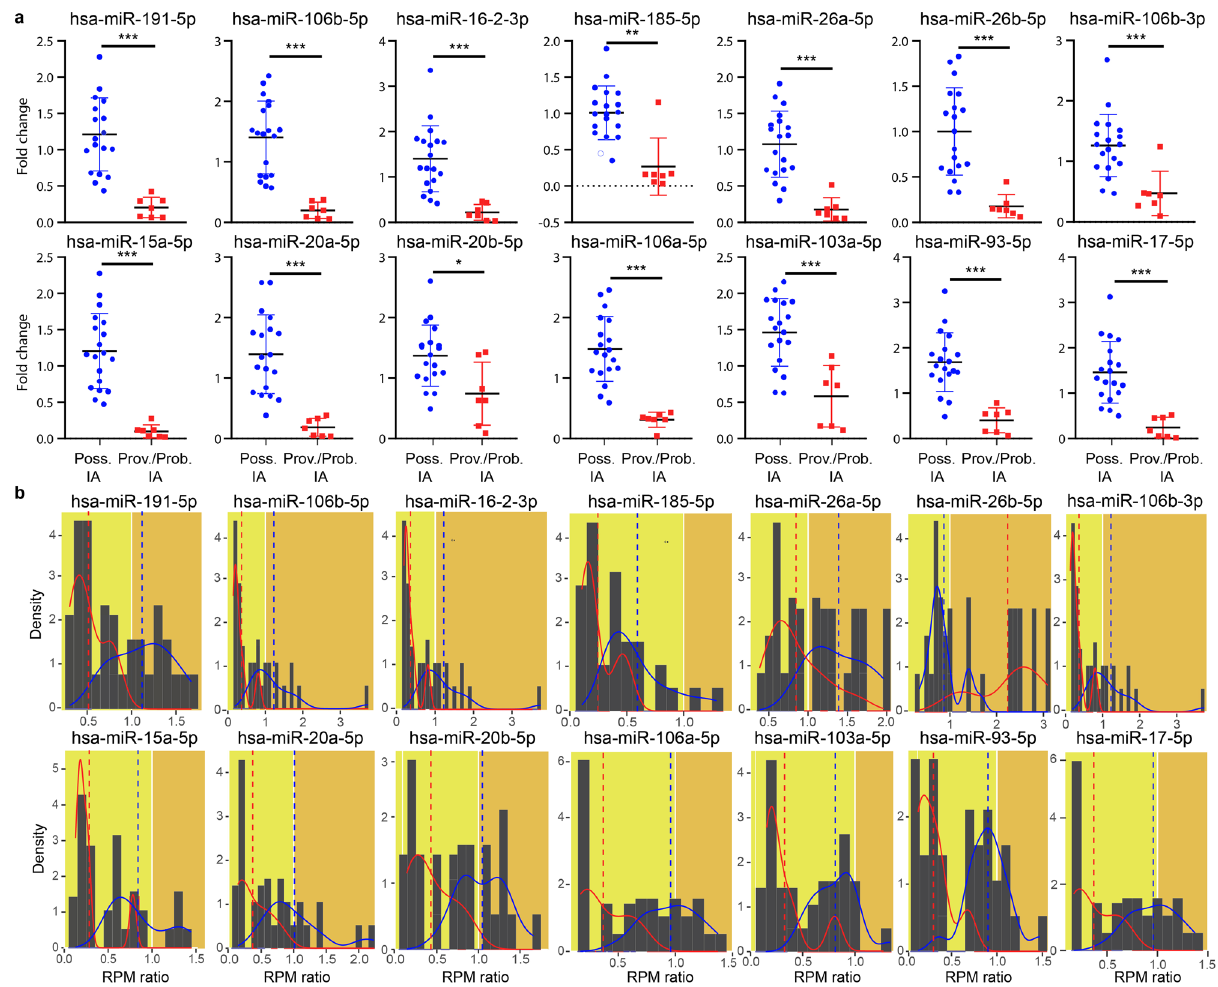
Figure 5. Representation of the fold changes in the qRT-PCR data and sequencing read numbers with their density distributions of validated DEMs measured in the whole blood of IA-infected and noninfected HO patients. ( a ) The downregulated gene expression of 14 DEMs was confirmed by qRT-PCR. Scatter plots represent the whole blood miRNA levels as relative miRNA concentrations with the formula 2-ΔCt (normalized to hsa-miR-181a-5p). Significant median differences in the miRNA levels between each group were determined by the nonparametric Mann–Whitney test (* P < 0.05, ** P < 0.01, *** P < 0.001). ( b ) Density bars represent the normalized sequencing read numbers in patients relative to healthy controls, where the trend line indicates IA-infected (red) and noninfected (blue)